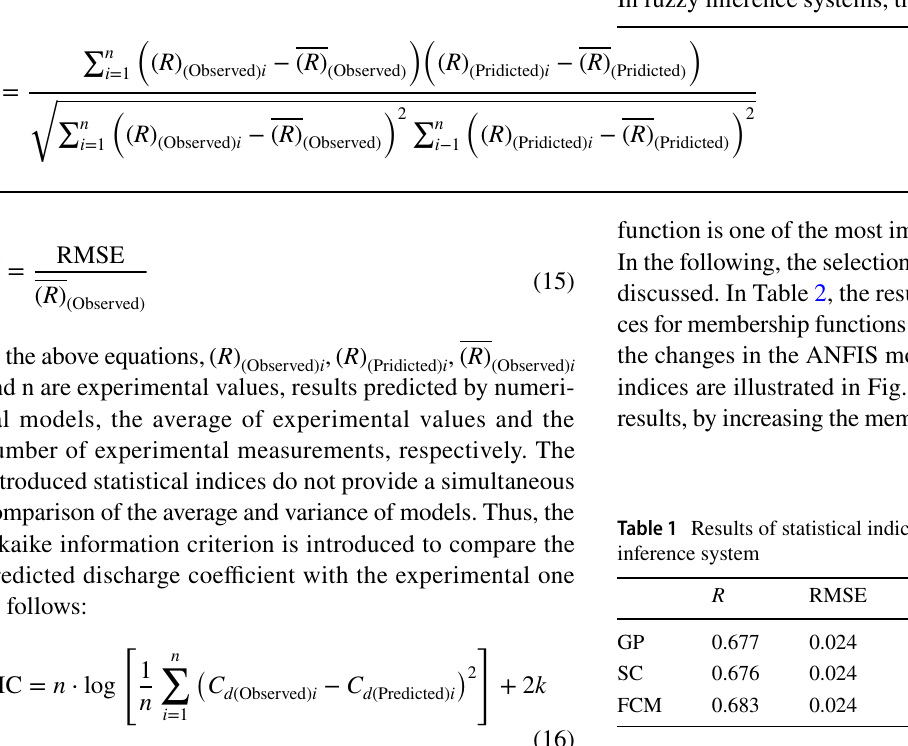
Fig. 5 Dealing with observational data in k -fold cross-validation method